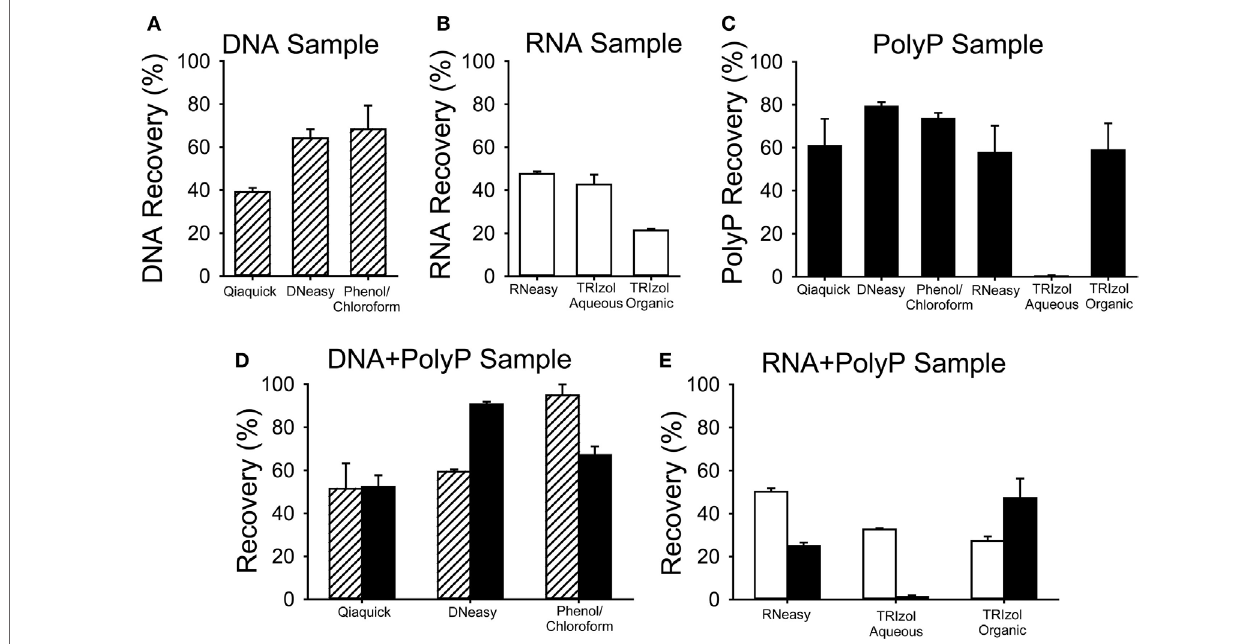
FigUre 2 | Recovery of nucleic acids and polyphosphate (polyP) using various purification methods. Known quantities of bacteriophage lambda DNA (DNA, striped bars), polyG (RNA, white bars), or long-chain polyP (black bars) were processed for nucleic acid purification using Qiaquick, DNeasy, or TRIzol kits, following the manufacturer’s instructions, or with phenol/chloroform extraction. Nucleic acid recovery was quantified using A 260 and polyP recovery by digestion with PPX1 and PiBlue assay. Results are plotted as percent of the input amount in each experiment. For all experiments except the Qiaquick kits, the three samples were: (a) DNA alone (5 µg lambda DNA); (B) RNA alone (5 µg polyG); (c) 5 µg polyP alone; (D) a mixture of 5 µg polyP plus 5 µg of DNA; or (e) 5 µg polyP plus 5 µg of RNA (e) . Experiments with the Qiaquick kit employed 2.5 µg of polyP and/or nucleic acid. Data are mean ± SEM ( n =